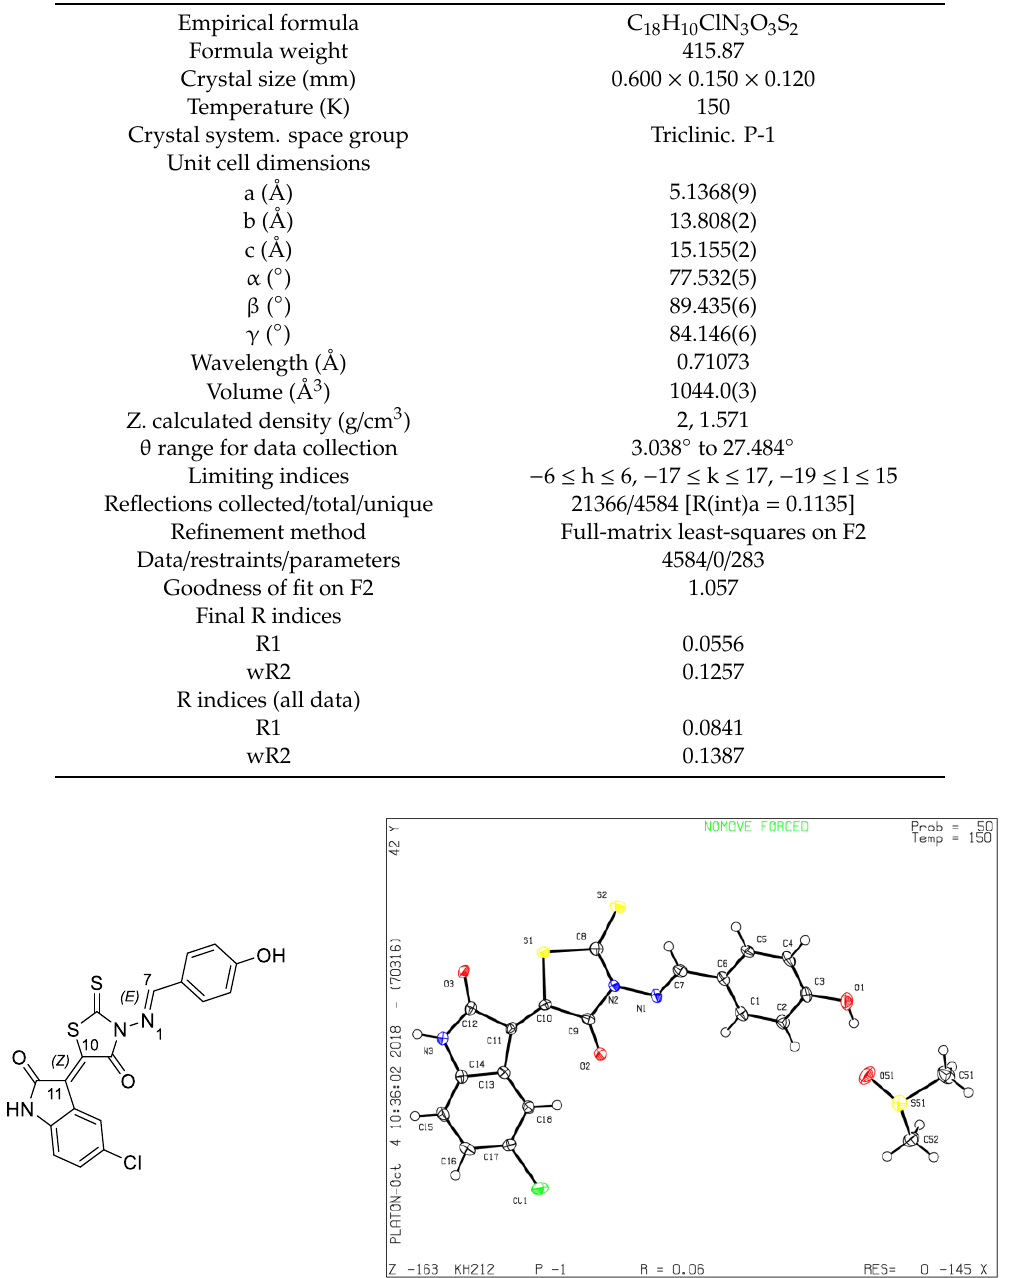
Table 1. Crystal data and structure refinement details.